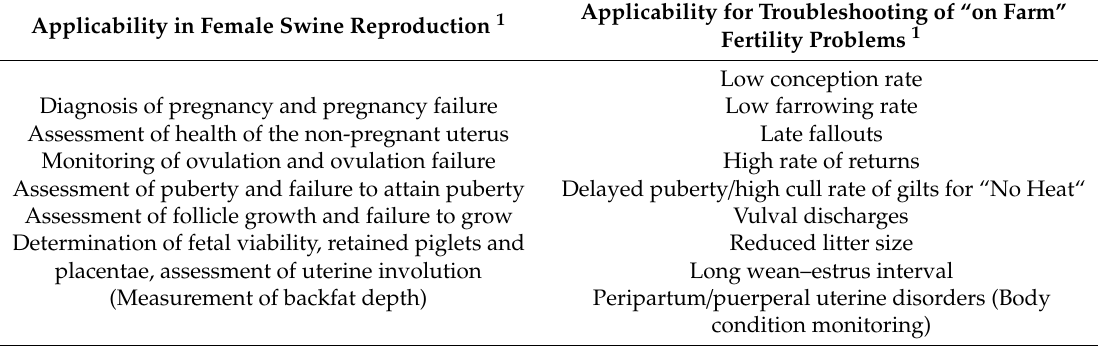
Table 2. Applicability of ultrasonography in female swine reproduction and for troubleshooting of “on farm” fertility problems